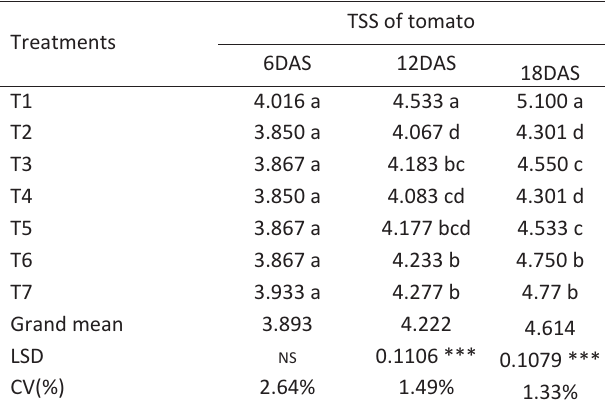
Table 3 ­ Effect of different packaging materials on TSS content